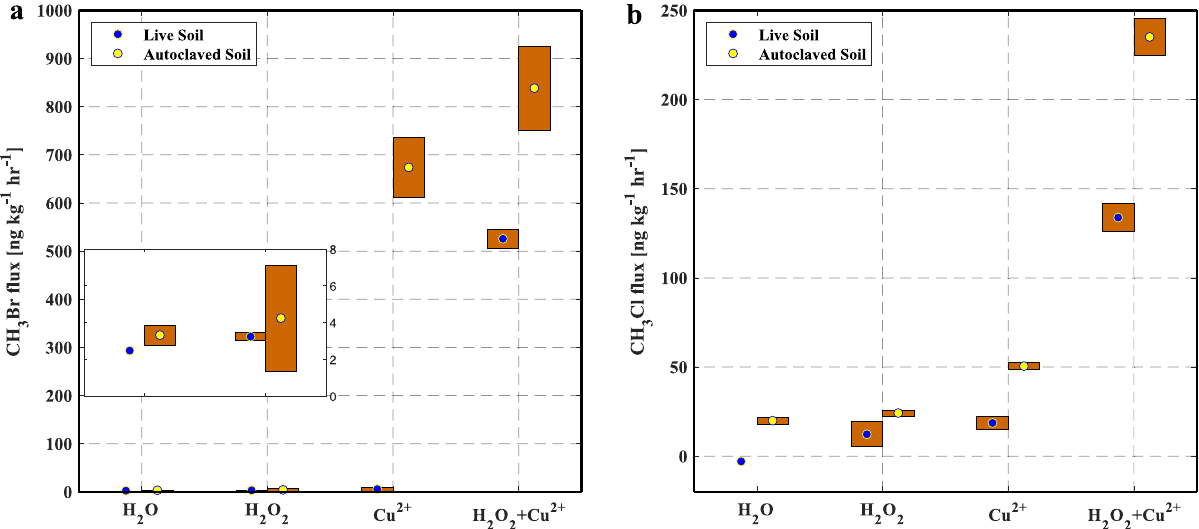
Fig. 2 Methyl halide fl uxes from soil samples amended with different chemicals. a Methyl bromide (CH 3 Br) and b methyl chloride (CH 3 Cl) fl uxes from live and autoclaved soil samples under different treatments. (i) 20 ml of deionized water was added; (ii) 10 ml each of deionized water and 50 mM H 2 O 2 was added; (iii) 10 ml each of deionized water and 50 mM CuSO 4 was added; (iv) 10 ml each of 50 mM H 2 O 2 and 50 mM CuSO 4 at were added. The dots represent the average fl uxes of two replicated incubations ( n = 2) in each treatment and the upper and lower boundary of the bars represent the two individual fl uxes. The inserted plots in ( a ) are the enlarged view of CH 3 Br fl uxes from soils in the fi rst two